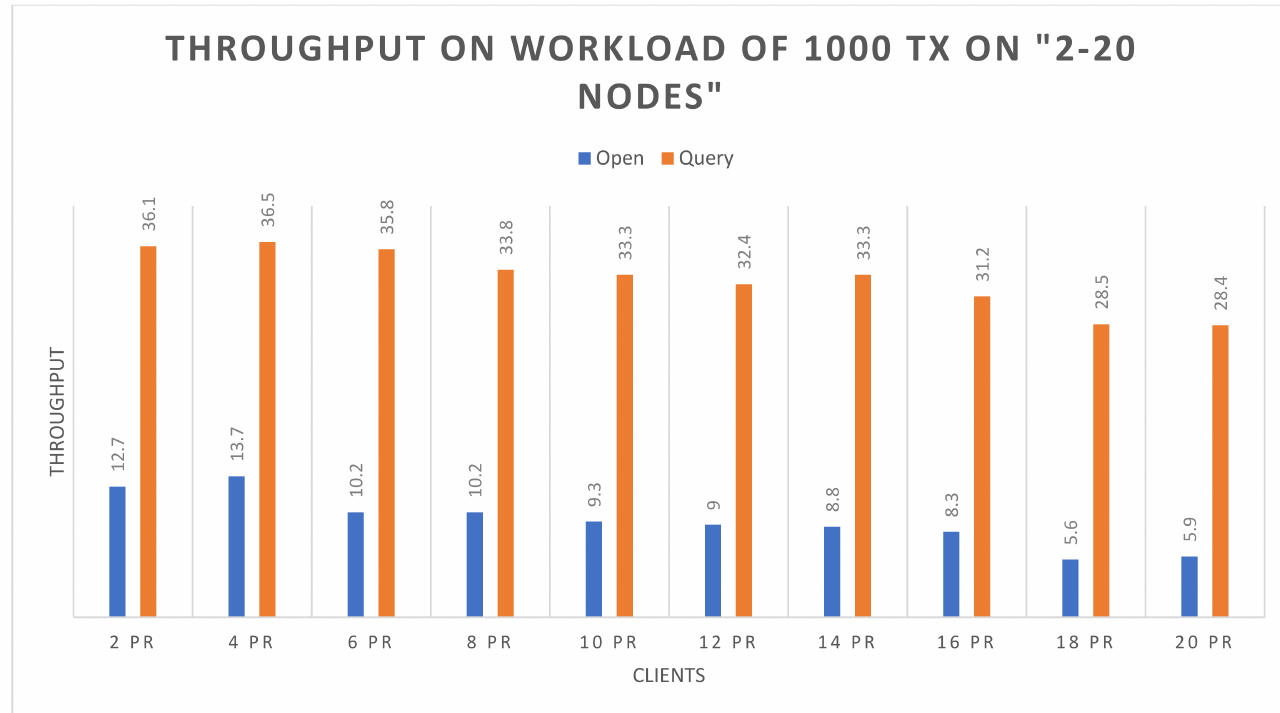
Figure 7. Throughput on 1000